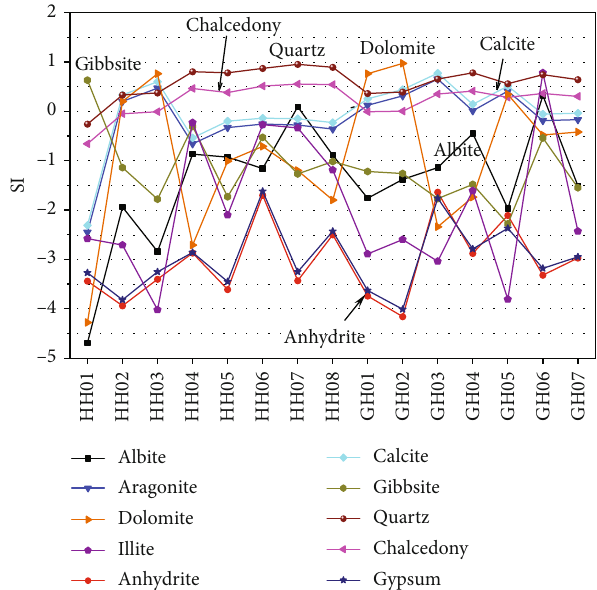
Figure 8: Saturation indices (SI) of the main minerals for the hot springs in study